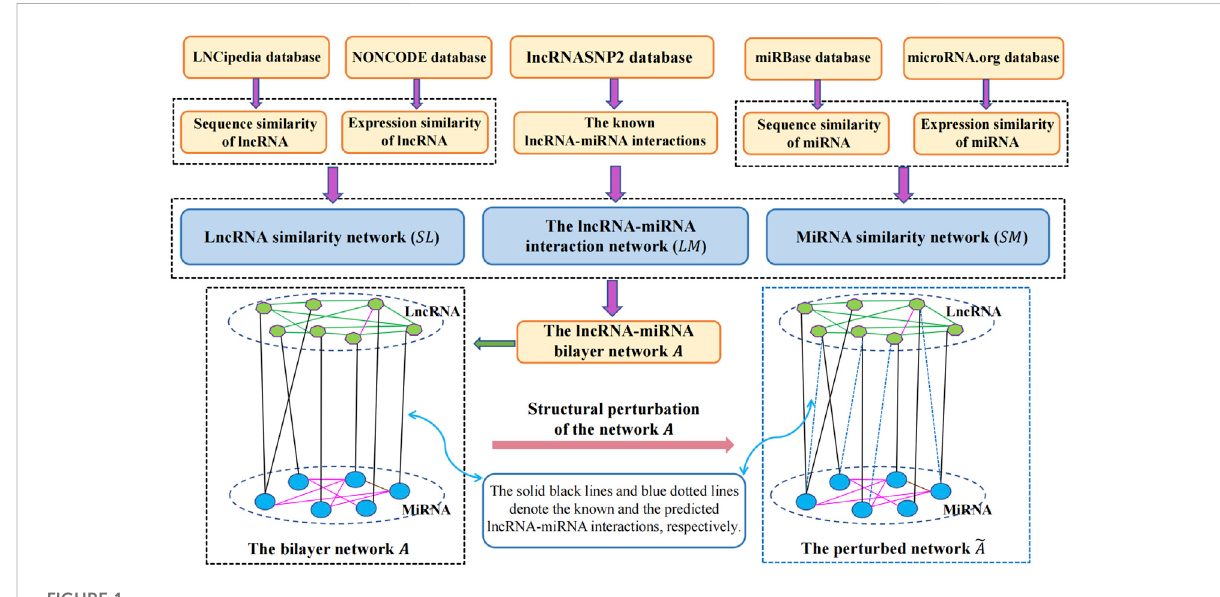
FIGURE 1 Flowchart of the prediction process of